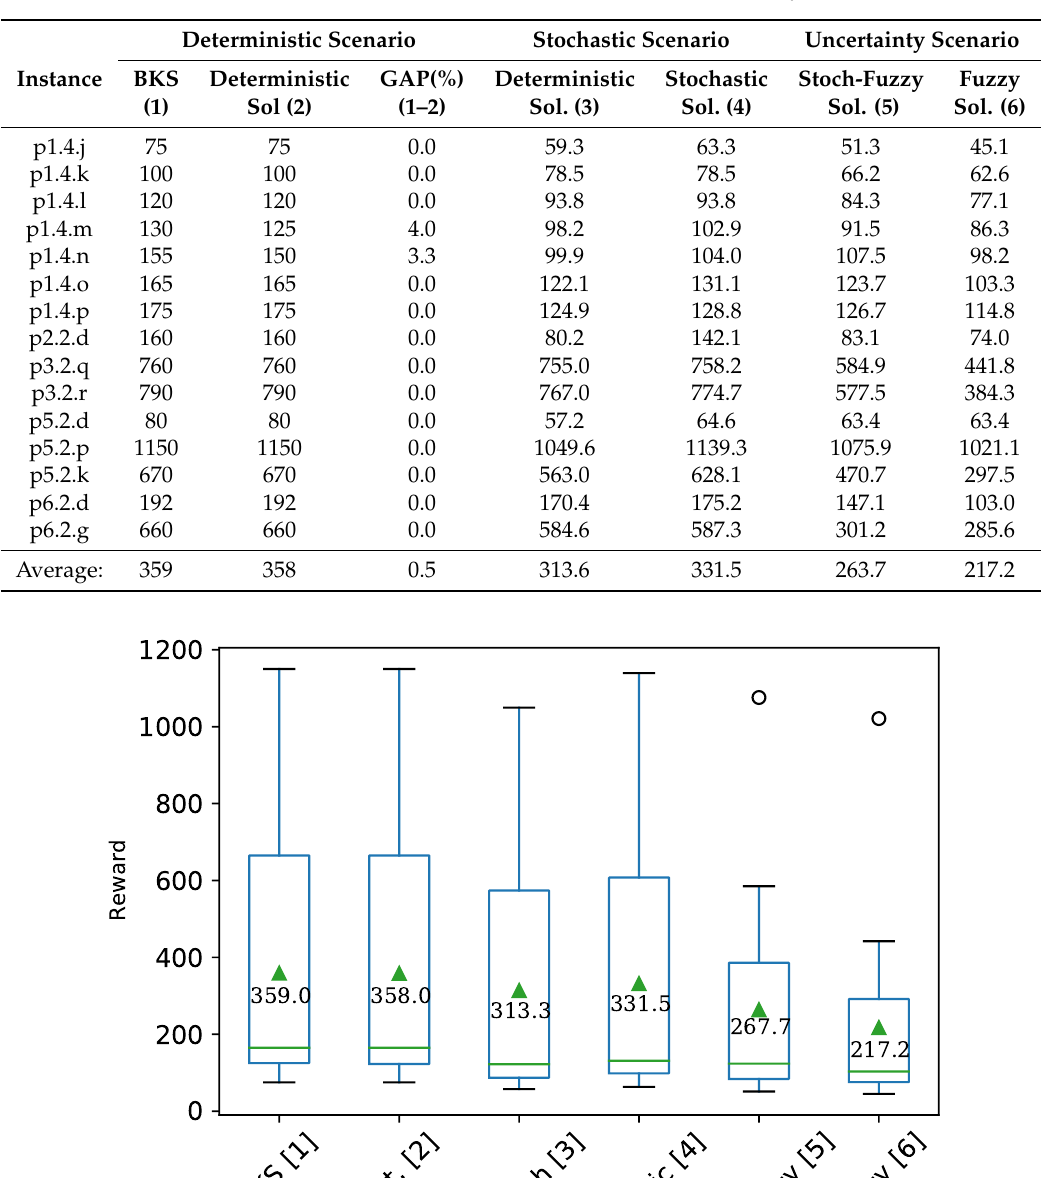
Table 2. The results of the deterministic, stochastic, and fuzzy TOP.